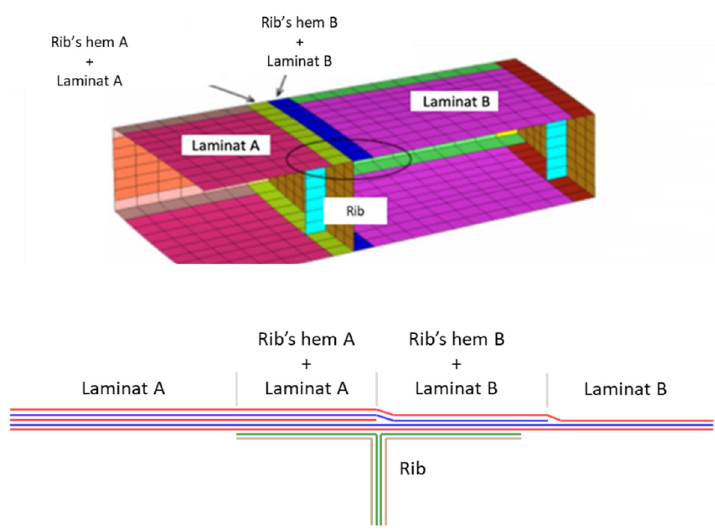
Figure 10. Example of connection reduction.